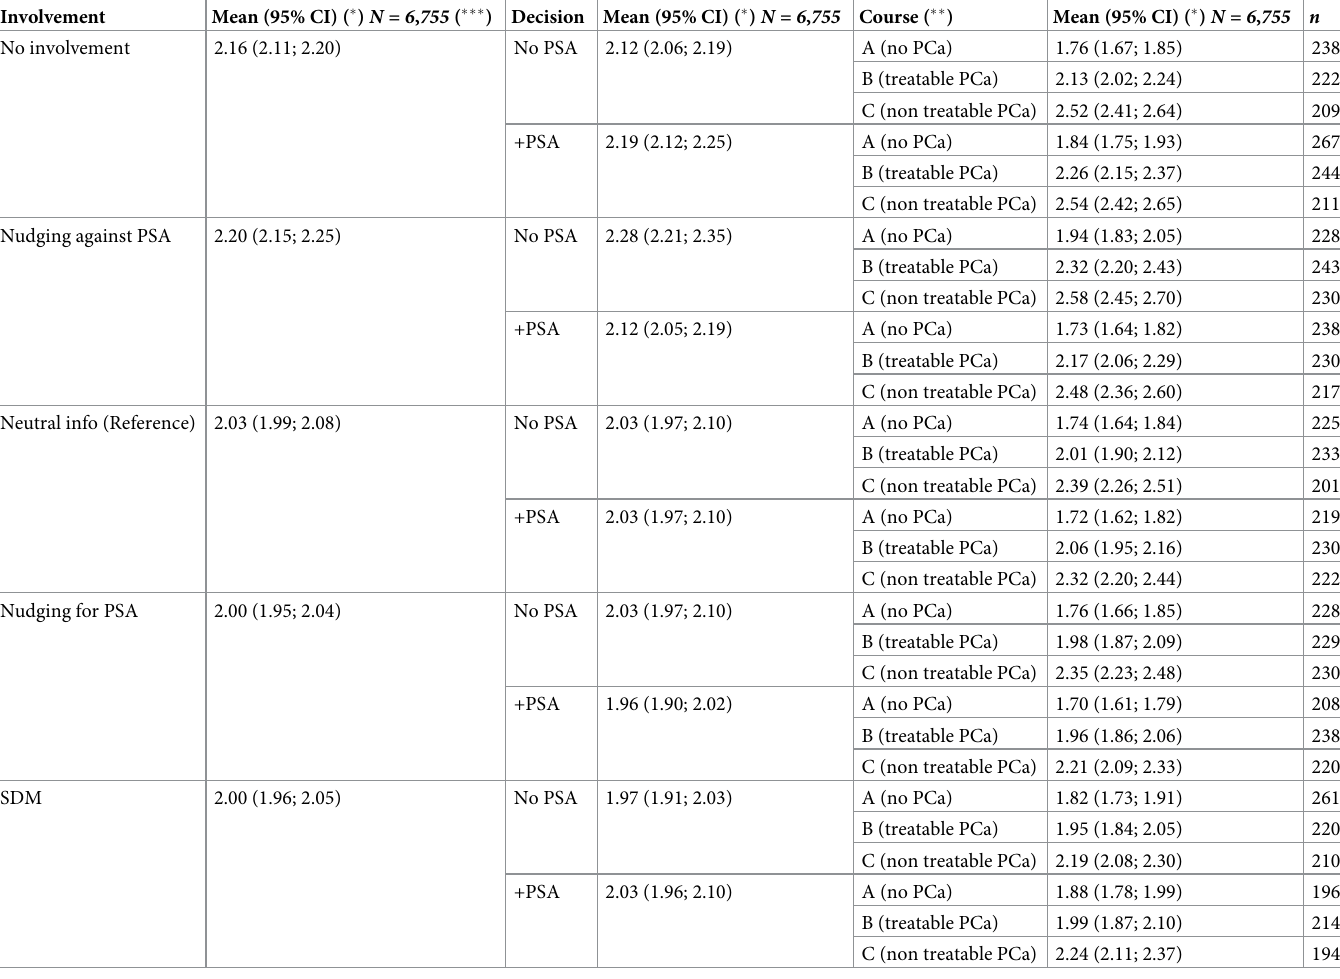
Table 2. Respondents’ wish to complain, different levels of involvement, decisions and